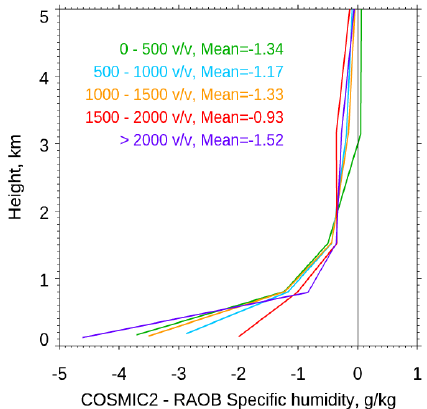
Figure 14. Similar to Figure 13 but for COSMIC-2 water vapor profiles from the surface to 5 km altitude for different SNR groups. Table 4. The mean COSMIC-2 – RS41 difference of the water vapor profiles from the surface to 5 km altitude for five SNR groups.